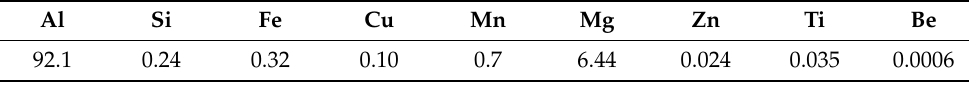
Table 1. Chemical composition of AlMg6 (percentage by weight).